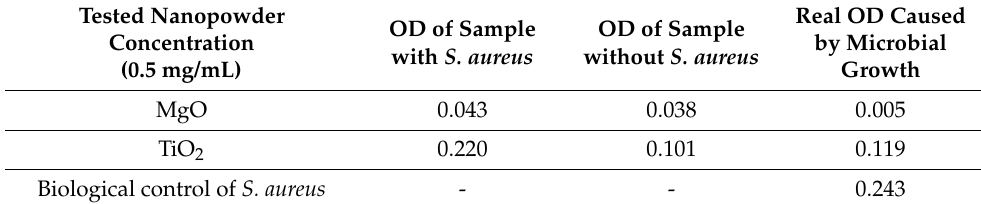
Table 3. Optical density at 600 nm of MgO and TiO 2 nanopowders after 24